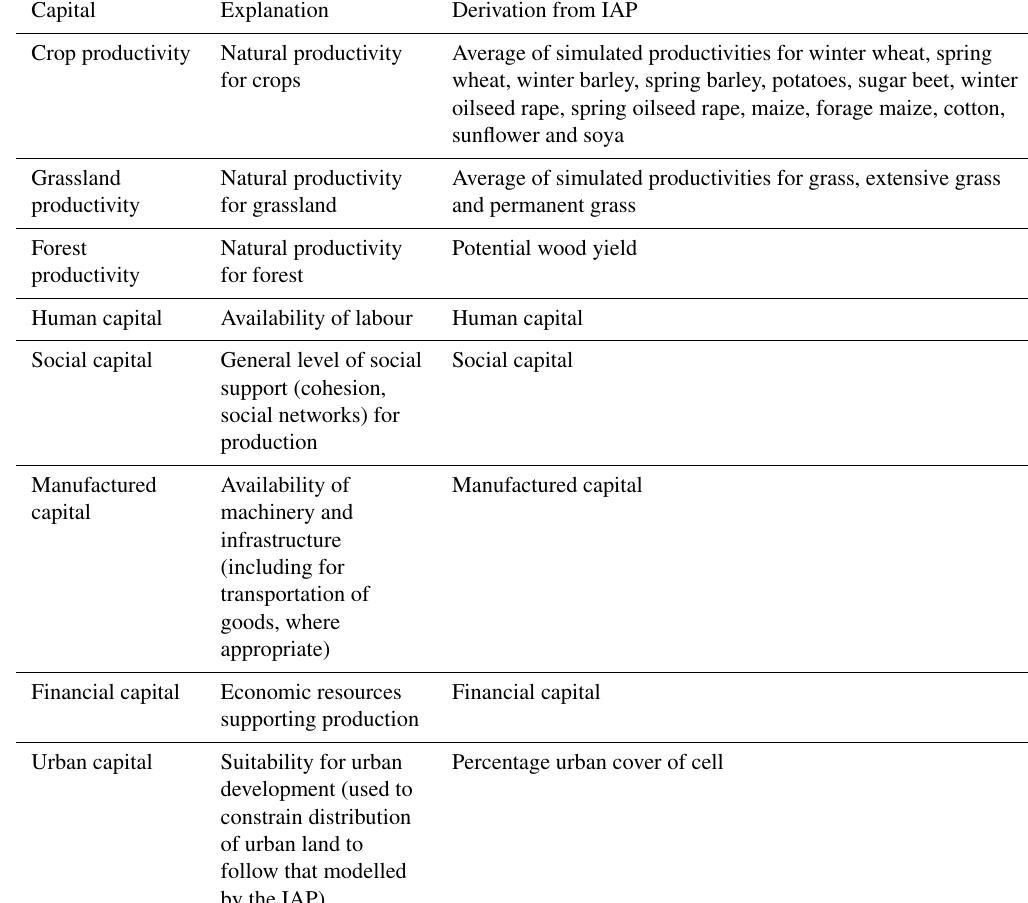
Table A2. Identities and details of modelled capitals. Exact parallels for some capitals were available in the